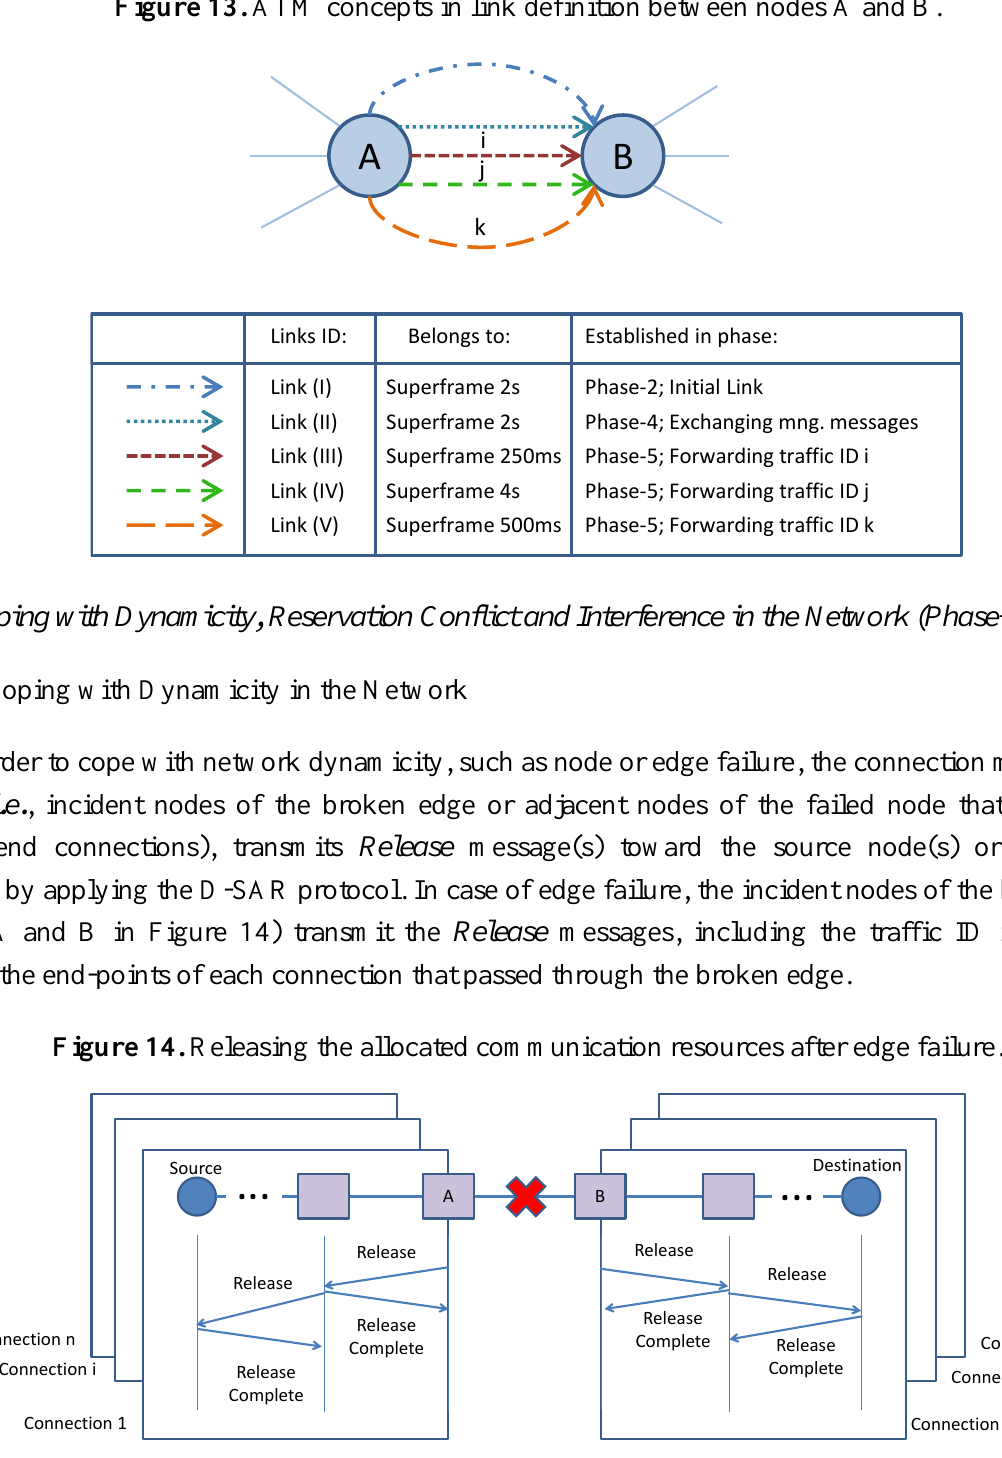
Figure 13. ATM concepts in link definition between nodes A and B.